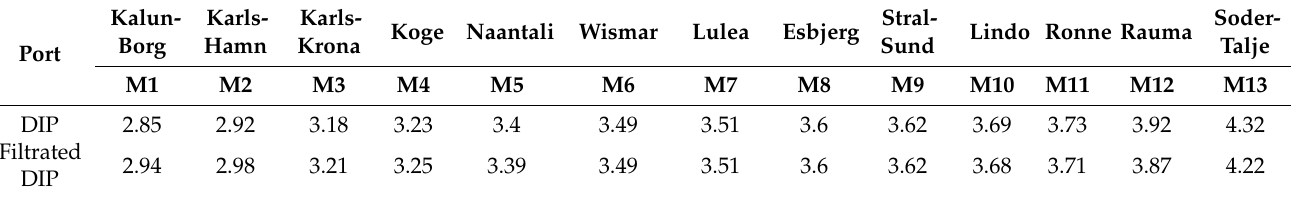
Table 5. DIP score values calculated for medium-sized ports.